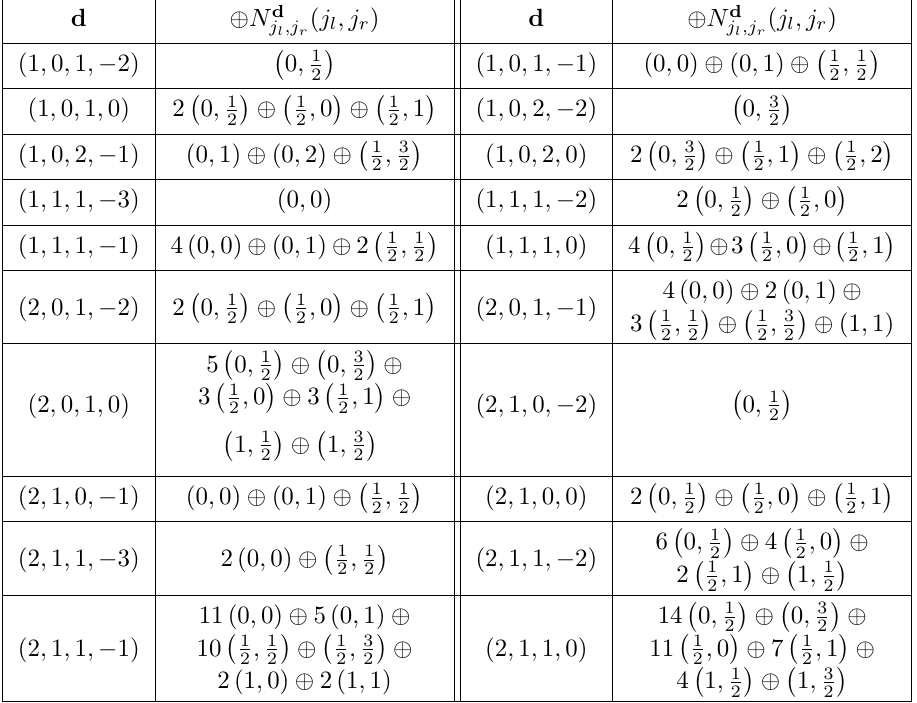
Table 21. BPS spectrum of the Sp(2) 0 + 1 Adj theory for d 1 = 1 , 2 and d 2 ≤ 1 , d 3 ≤ 1 . Here, d = ( d 1 , d 2 , d 3 , d 4 ) labels the BPS states with charge d 1 m 0 + d 2 α 1 + d 3 α 2 + d 4 m 1 where α 1 = 2 φ 1 − φ 2 , α 2 = − 2 φ 1 +2 φ 2 are simple roots of sp (2) algebra. The theory has a symmetry exchanging d 4 ↔ − d 4 which provides BPS states with flipped charge d 4 → − d 4